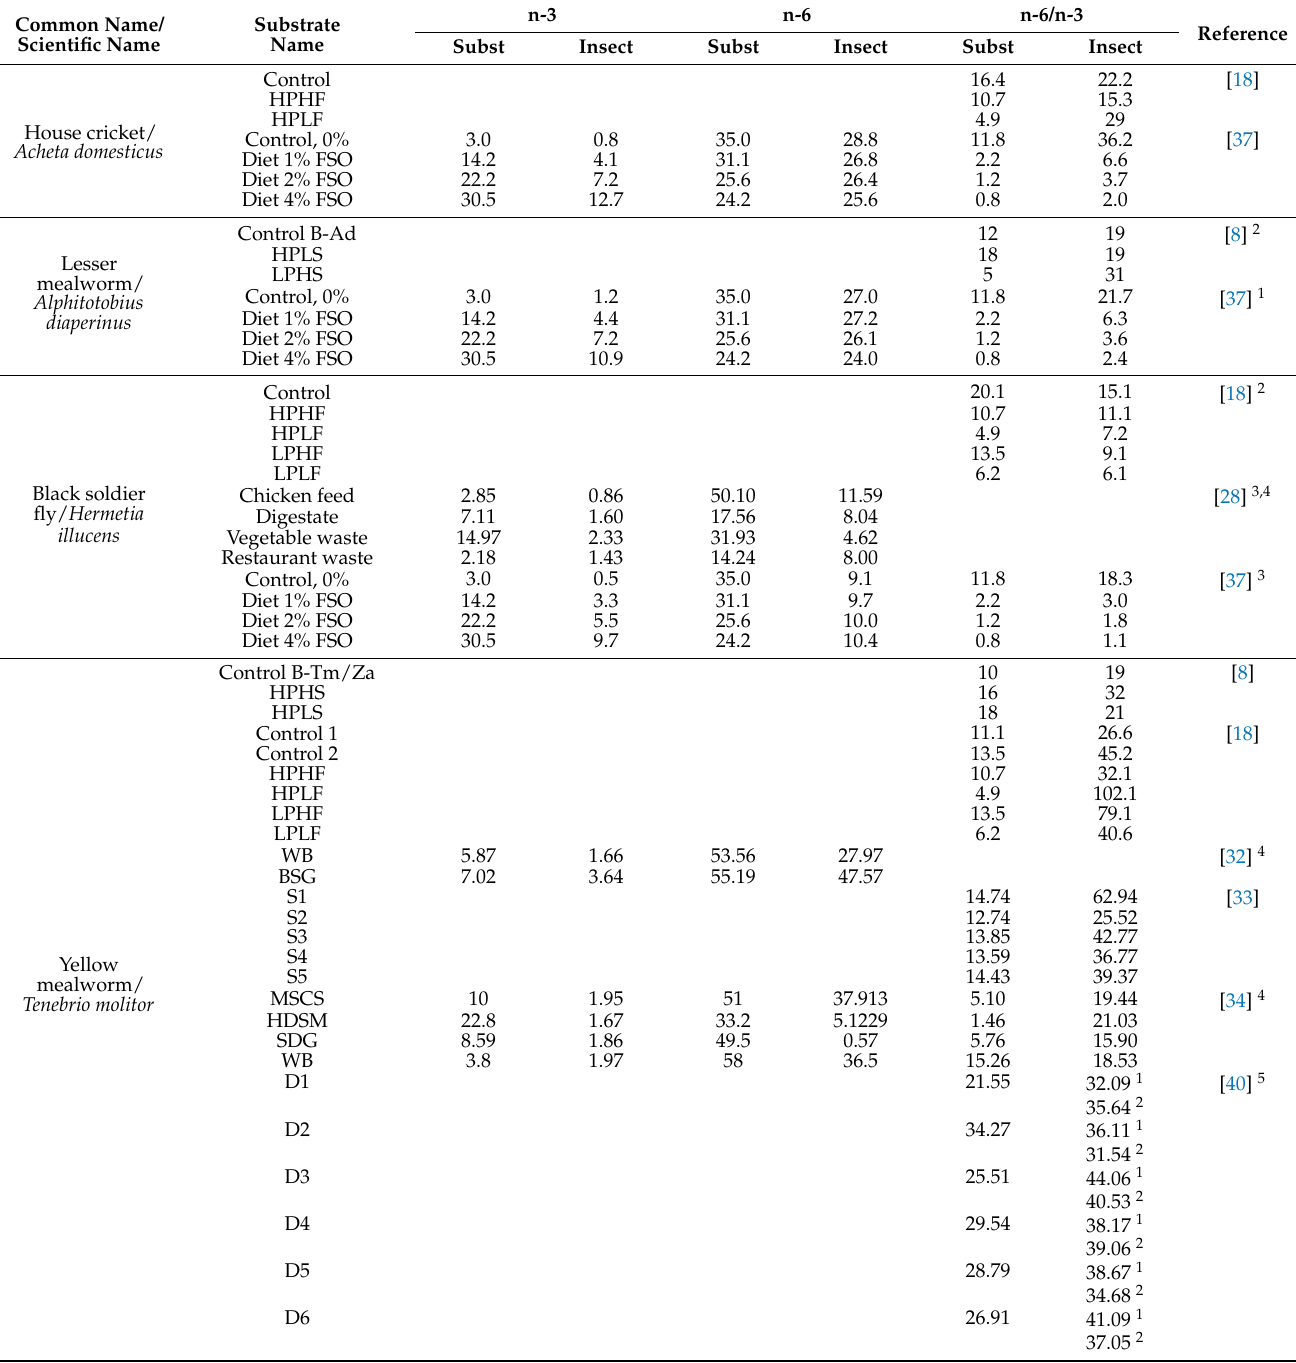
Table 2. Contents (% of total fatty acids) of n-3 fatty acids and n-6 fatty acids and the ratio of n-6 and n-3 in feed substrates and in